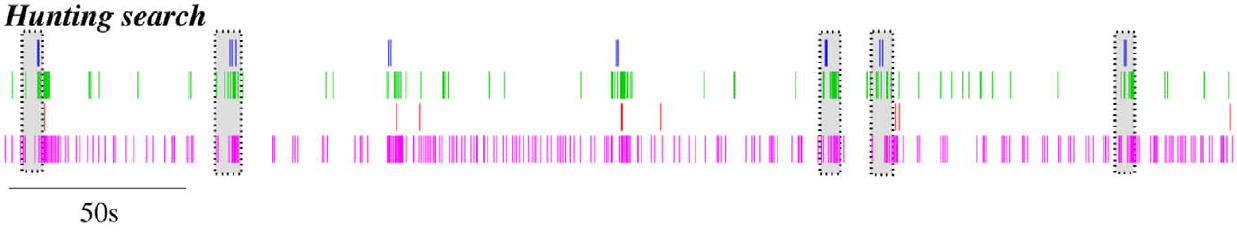
Figure 2. A representative recording of SRC firing activity in the biological system. Spikes times of four SRC units during fictive hunting search behavior evoked by physostigmine in vitro . The activity was recorded extracellularly and the spikes were sorted as explained in [16]. Note the irregular sequential alternation in firing between different SRCs during hunting. During these experiments there is no motion and thus the WLC activity arises from the excitation of the hunting neuron to the SRCs. Grayed areas illustrate specific sequential activations among active